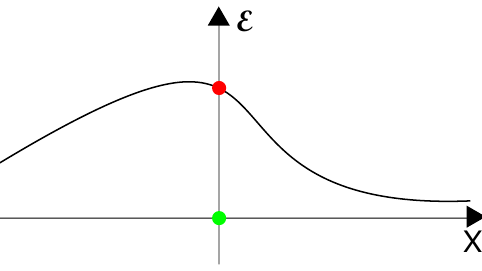
Figure 13 . Electric (cid:12)eld on the horizon due to insertion of a singe Wilson line puncture from the L-wedge and R-wedge perspective. From Minkowski perspective, only the transverse (cid:13)ux